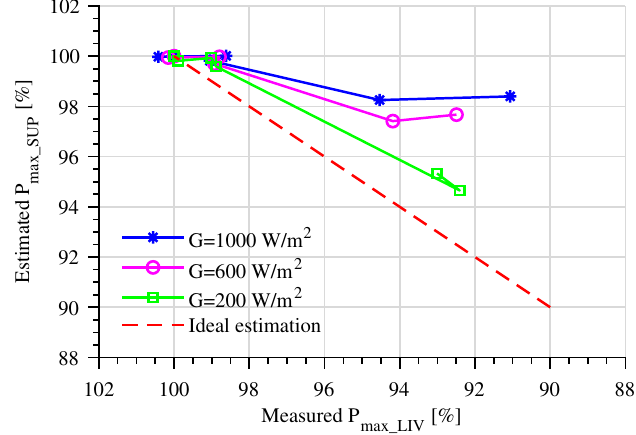
Figure 7. Estimated module #1 power loss by simple dark I-V superposition ( P max _ SUP ), versus actual measured power loss ( P max _ LIV ), at 1000, 600, and 200 W/m 2 irradiance.